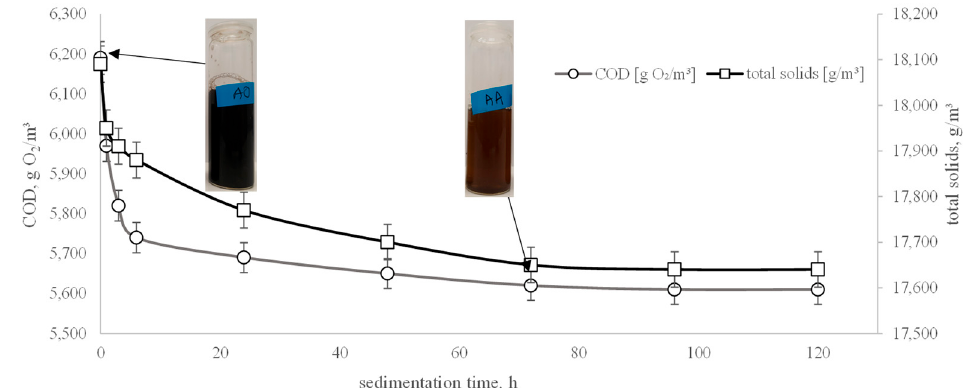
Figure 2. Influence of sedimentation time on the effectiveness of COD and total solid reduction in the liquid fraction of digestate.